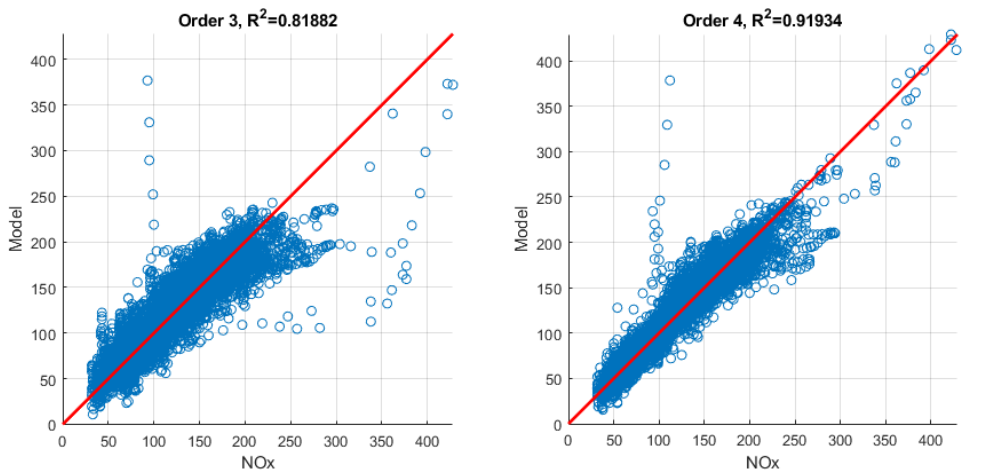
Figure 9. Correlation of predicted and original data for all 11 variables.